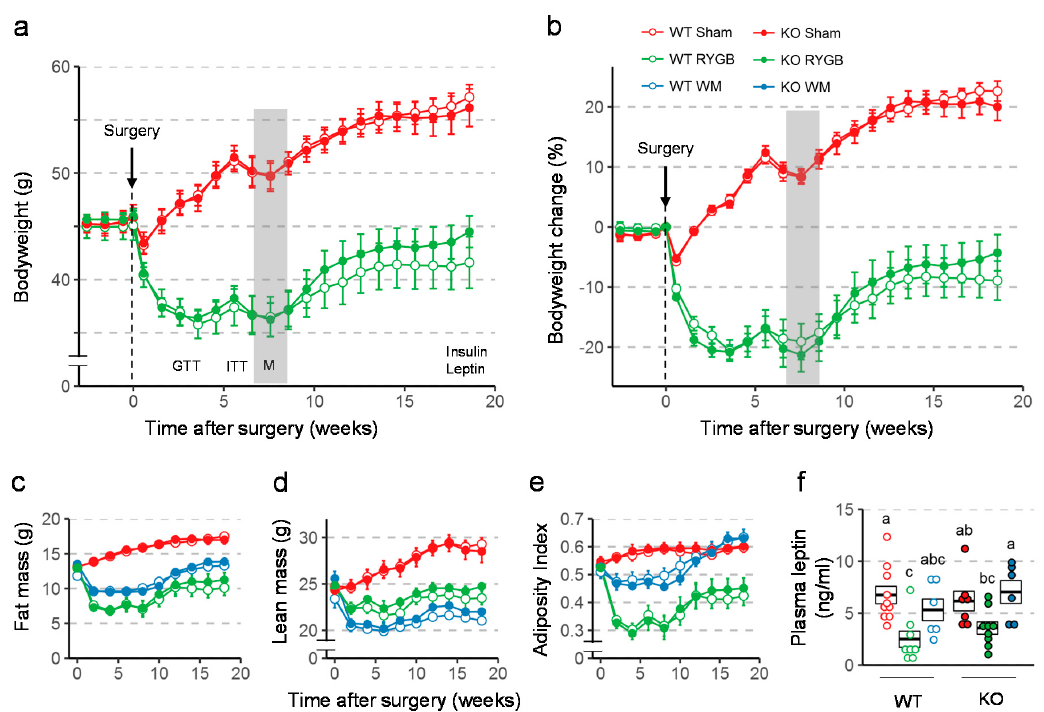
Figure 2. Effect of RYGB or sham surgery, or weight matching to RYGB by caloric restriction (WM) on body weight, body composition, and leptin levels of Y2RKO and WT mice. ( a , b ): Effect on absolute body weight and percent body weight change over the 18-week observation period. Body weight of WM mice was, by design, similar to RYGB and is not shown. Timing of glucose tolerance test (GTT), insulin tolerance test (ITT), and metabolic chamber exposure (M, gray bar) are shown in A. ( c – e ): Effect on fat mass ( c ), lean mass ( d ), and adiposity index ( e ) over the 18-week observation period. ( f ): Plasma leptin levels at termination of the study. Data in a-e are shown as means ± SEM. Data in f are presented as individual data points over a box showing means ± SEM. Groups that do not share the same letters are significantly different from each other ( p < 0.05, pairwise t -tests with Benjamini–Hochberg correction, false discovery rate (FDR) =